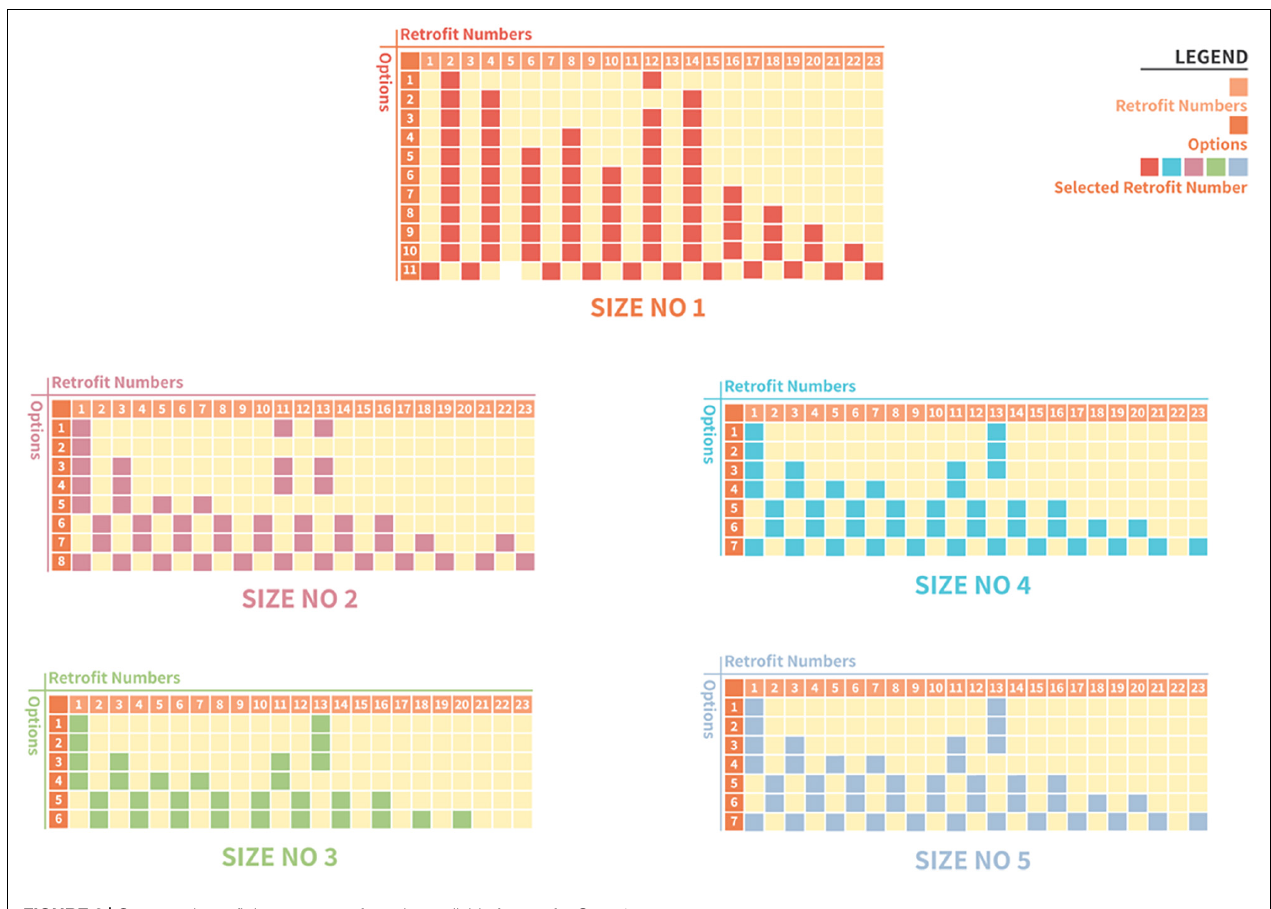
FIGURE 6 | Generated retrofitting measures from the available factors for Case